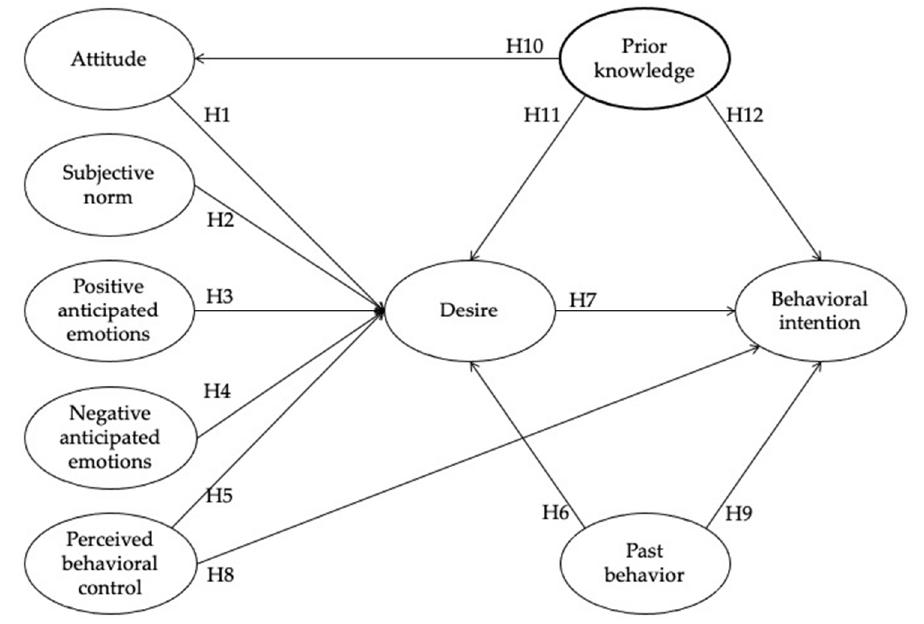
Figure 1. Research model with hypotheses.